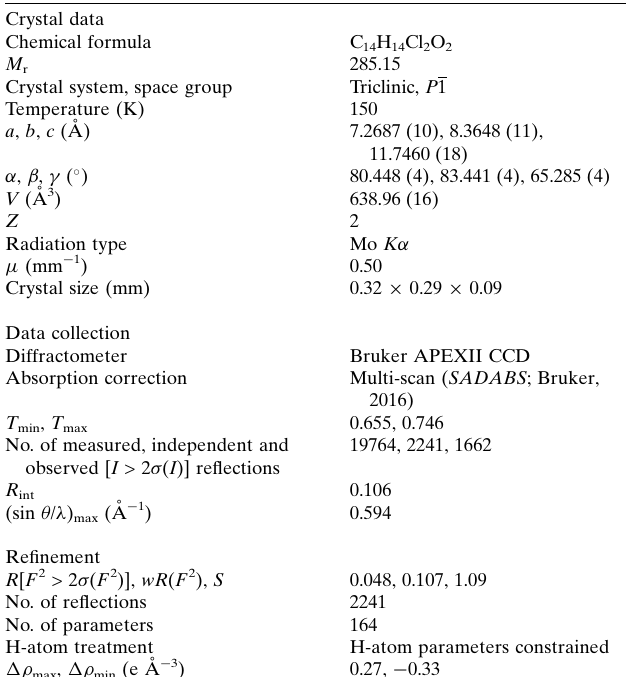
Table 2 Experimental